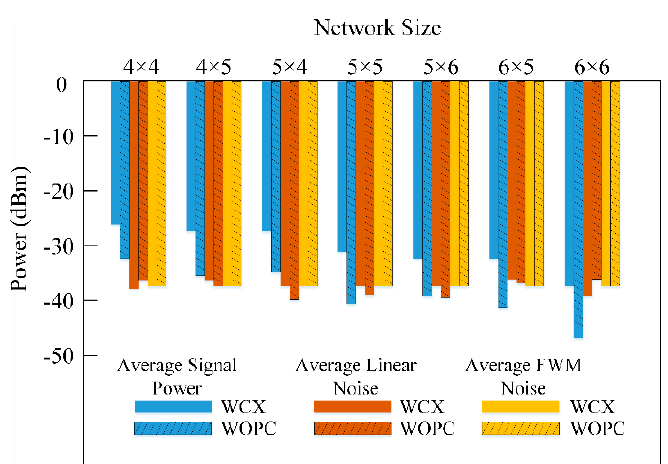
Figure 10. The comparison of average signal power, linear noise, and nonlinear FWM noise under different network sizes.